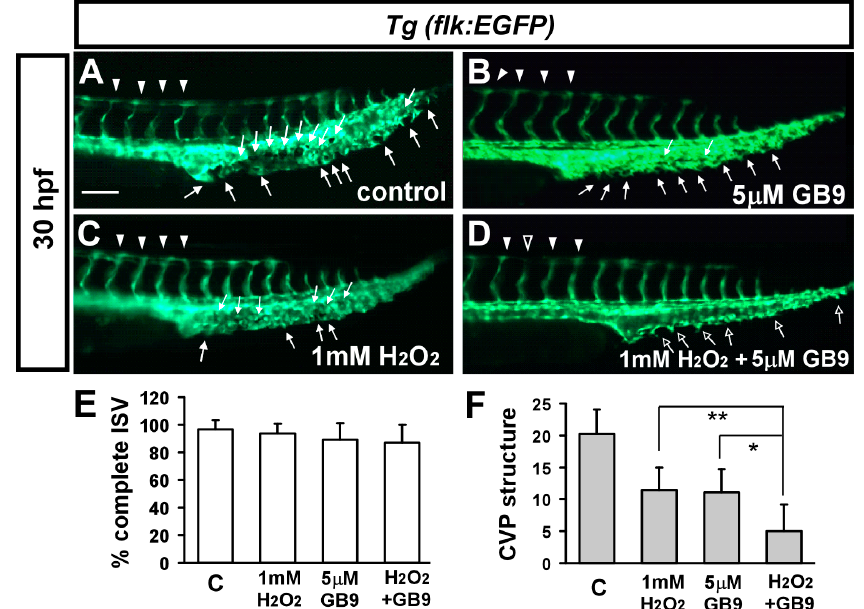
Figure 6. Enhanced effects of vascular defects while GB9 and H 2 O 2 co-treatment. ( A – D ) Enhanced effects by combined lower dosage of GB9 treatment and lower dosage of H 2 O 2 treatment embryos. At 30 hpf, in untreated control embryos ( A ), ISV have reached the DLAV ( arrowheads ) and the CVP with sprouting and/or loop ( arrows ) structures at the tail. Lower dosage of GB9 (5 μ M) treatment embryos ( B ) or lower dosage of H 2 O 2 (1 mM) treatment ( C ) showed mild or no effects in ISV growth and CVP development. Combination of GB9 treatment embryos and H 2 O 2 treatment showed very mild vascular defects in ISV growth ( hollow arrowheads in ( D )) but strong effect in CVP formation ( less arrows in ( D )). ( E , F ) Quantification of percentage of completed ISV and CVP integrity showed an enhanced reduction in GB9 and H 2 O 2 co-treated embryos ( n = 11 for control, n = 10 for GB9 treatment, n = 11 for 1 mM H 2 O 2 treatment and n = 11 for GB9, H 2 O 2 -cotreated embryos) at 30 hpf. ** refers to p < 0.001 and * refers to p < 0.01 by one-way ANOVA followed by Tukey’s post-test. Scale bars are 100 μ m for ( A – D ).